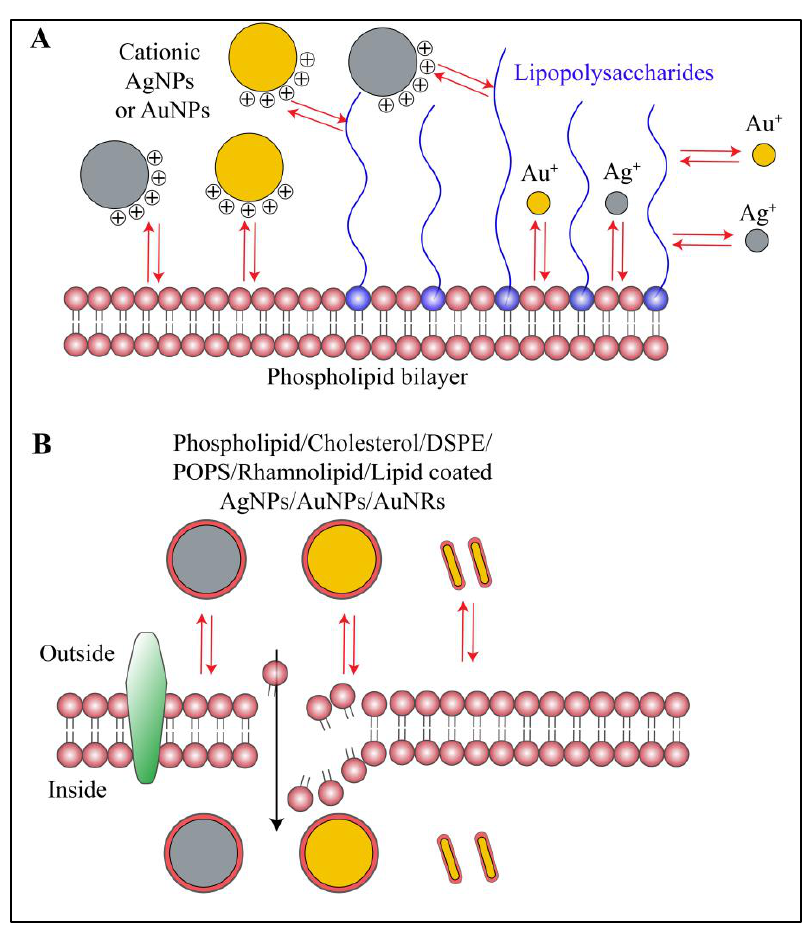
Figure 5. Schematic representation of interactions between biofilm lipids and gold or silver nanoparticles. ( A ) Cationic gold nanorods, gold nanoparticles and silver nanoparticles along with their respective ions interact with biofilm lipid and lipopolysaccharides via electrostatic and hydrophobic interactions. Whereas, anionic or neutral nanoparticles or nanorods show minimal or no interactions at all. ( B ) Gold nanorods, gold nanoparticles and silver nanoparticles coated with lipid moiety or any other hydrophobic moiety preferentially show hydrophobic interactions with biofilm lipids. Red arrows in the figure indicate different types of interactions.